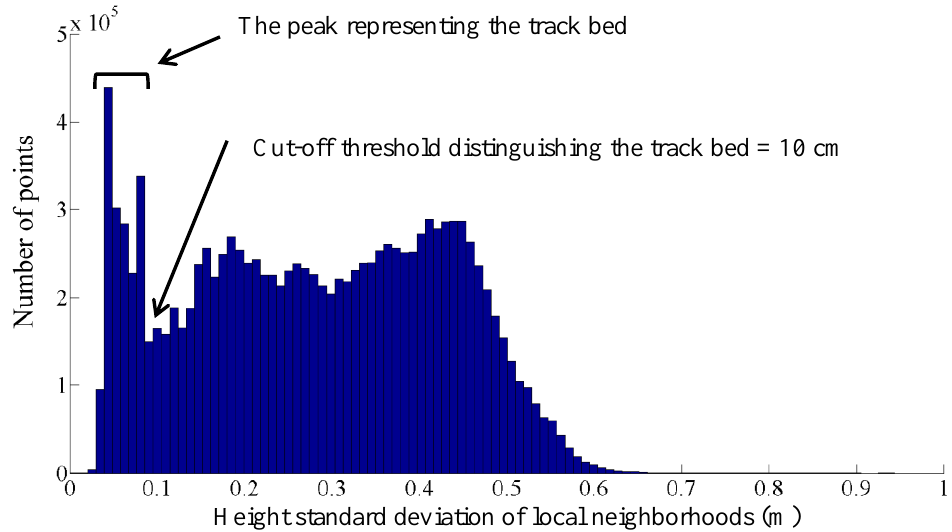
Figure 5. Histogram of height standard deviation of local